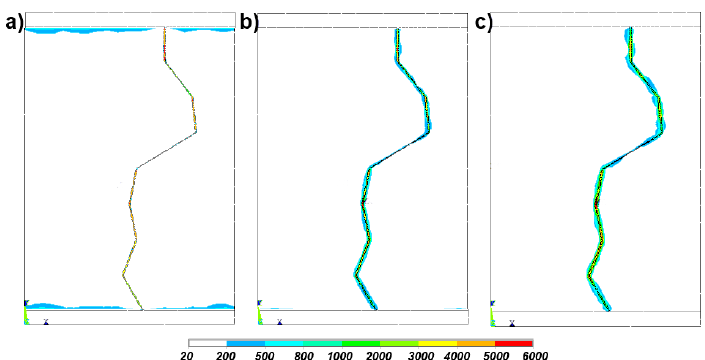
Figure 17. Temperature distribution in the sample in subsequent moments. ( a ) 0.0001 s; ( b ) 0.0005 s; ( c ) 0.001s.